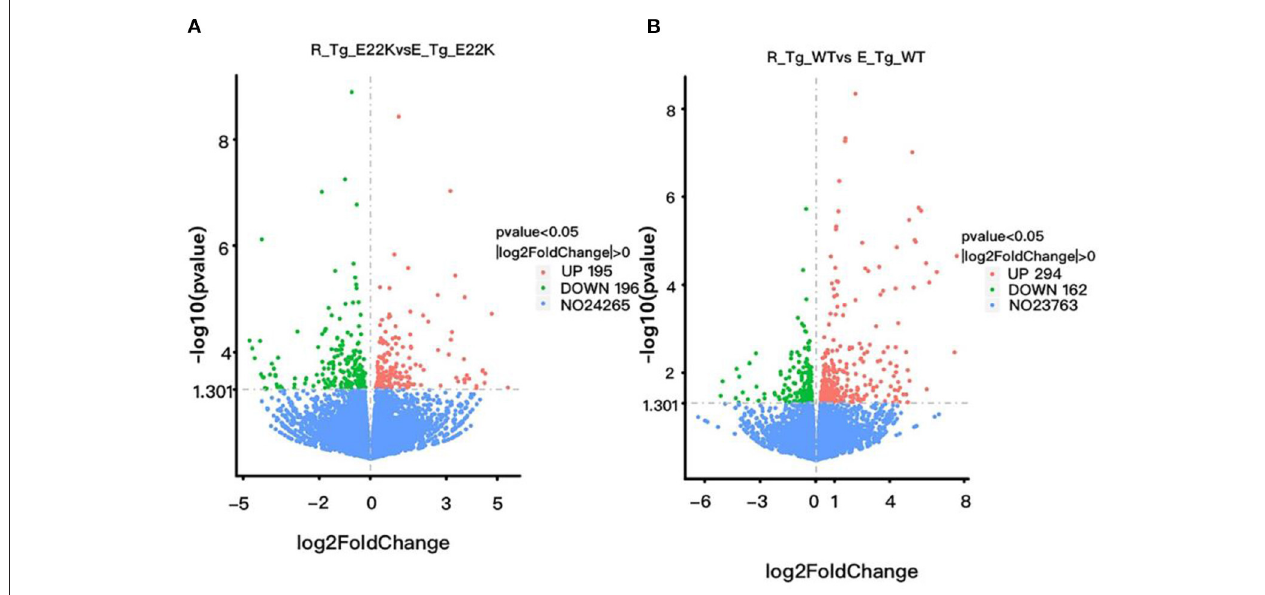
FIGURE 6 | Exercise regulates cardiac remodeling-related genes in mouse hearts. There were 391 genes with differential expression between R-Tg-E22K and E-Tg-E22K groups, of which 195 and 196 genes were upregulated and downregulated, respectively (A) . There were 456 genes with differential expression between R-Tg-WT and E-Tg-WT groups, of which 294 and 162 genes were upregulated and downregulated, respectively (B) . R-Tg-WT, wild-type transgenic mice in the rest group; R-Tg-E22K, transgenic E22K mice in the rest group; E-Tg-WT, wild-type transgenic mice in the exercise group; E-Tg-E22K, transgenic E22K mice in the exercise group.